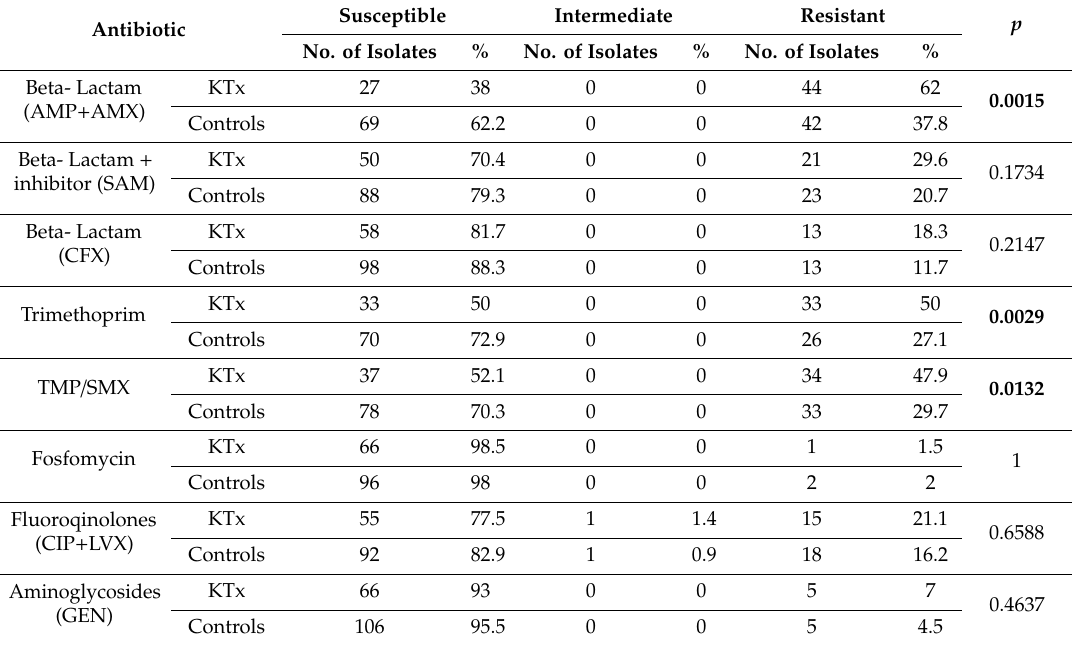
Table 5. Susceptibility patterns of KTx and control UPEC isolates.